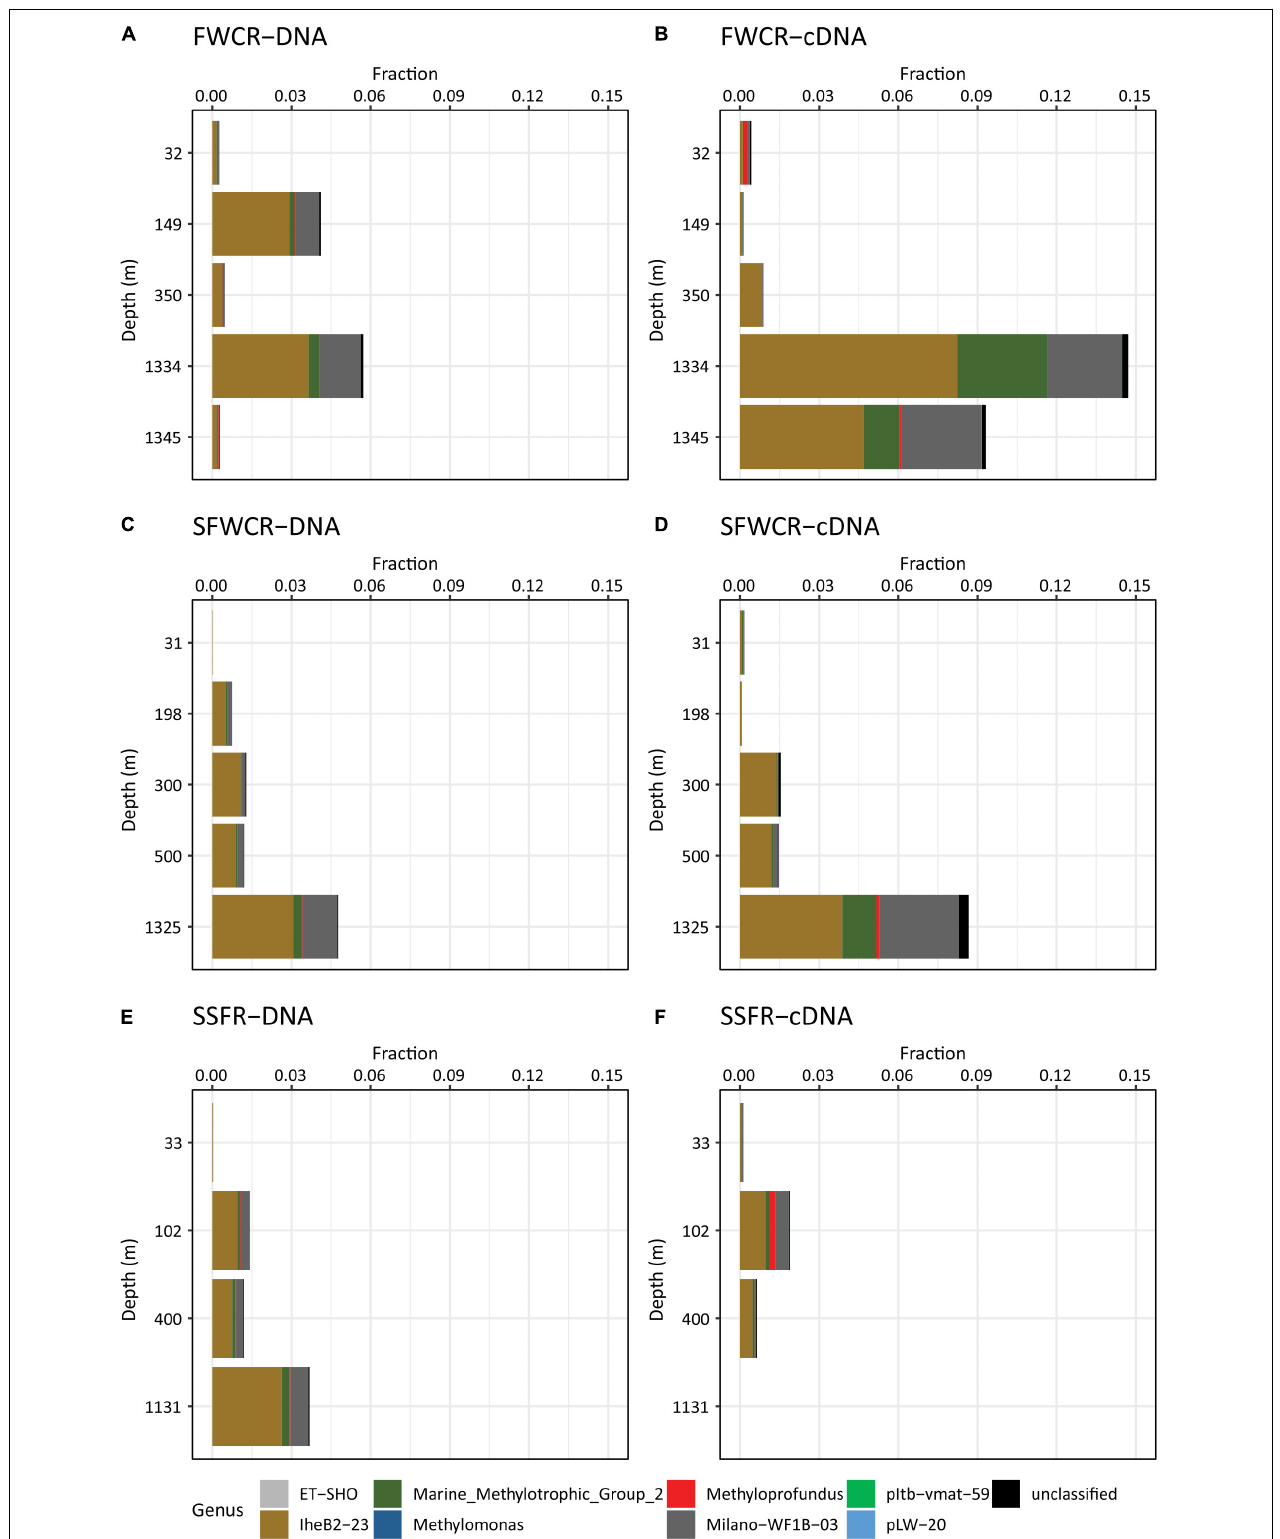
FIGURE 11 | The relative abundance of methanotrophs in the water column based on 16S rRNA gene sequences (A) above FWCR at DNA level (B) above FWCR at cDNA level, (C) above SFWCR at DNA level, (D) above SFWCR at cDNA level, (E) above SSFR at DNA level, (F) above SSFR at cDNA level.